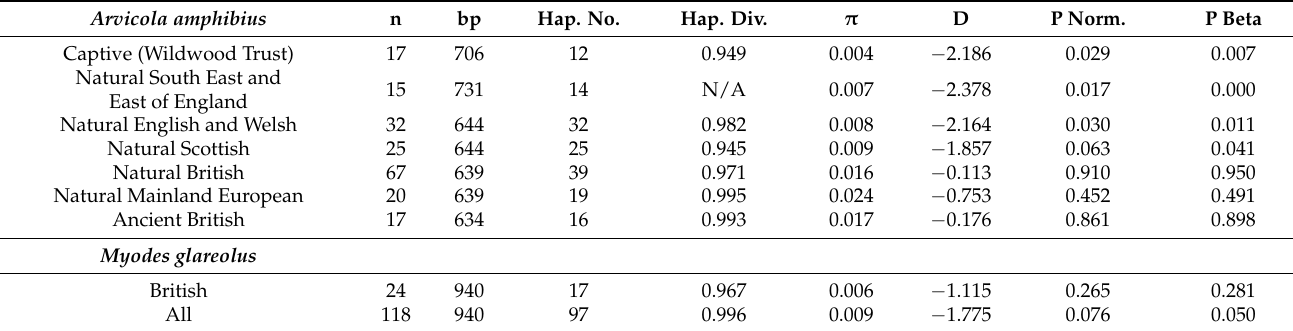
Table 1. Population genetics statistics of the mitochondrial DNA control region of European water voles ( Arvicola amphibius ) and bank voles ( Myodes glareolus ). Water vole statistics were calculated based on multiple sequence alignments containing sequences of modern captive water voles, modern natural water voles, and ancient museum specimens of British water voles from the Pleistocene and Holocene periods. Bank vole statistics were calculated using multiple sequence alignments of modern natural bank